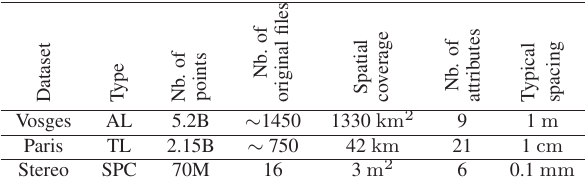
Table 1: Point cloud data-sets used, with some figures. AL stands for aerial lidar, TL for terrestrial lidar and SPC for stereo point cloud.